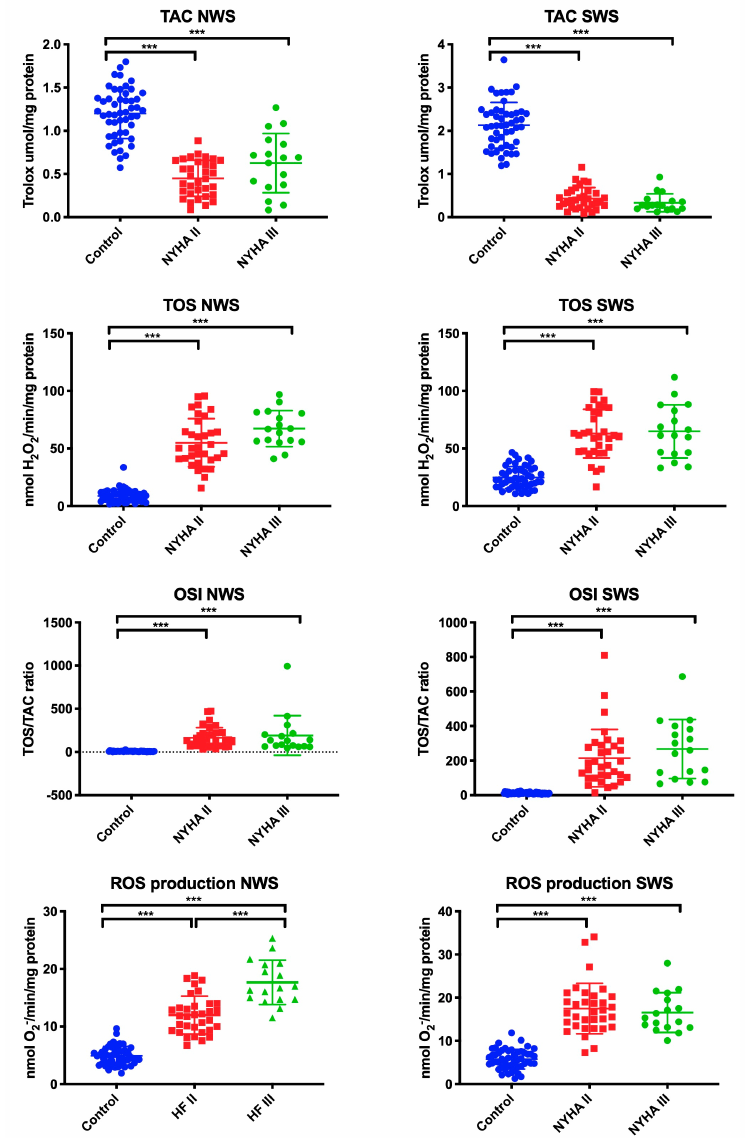
Figure 2. Total antioxidant/oxidant status in non-stimulated and stimulated saliva of HF patients and the control group. Abbreviations: NWS—non-stimulated whole saliva; NYHA II—class II in the New York Heart Association (NYHA) classification of the heart failure; NYHA III—class III in the New York Heart Association (NYHA) classification of the heart failure; OSI—oxidative stress index; SWS—stimulated whole saliva; TAC—total antioxidant capacity; TOS—total oxidant status. Di ff erences statistically important at: p ** < 0.01, *** <